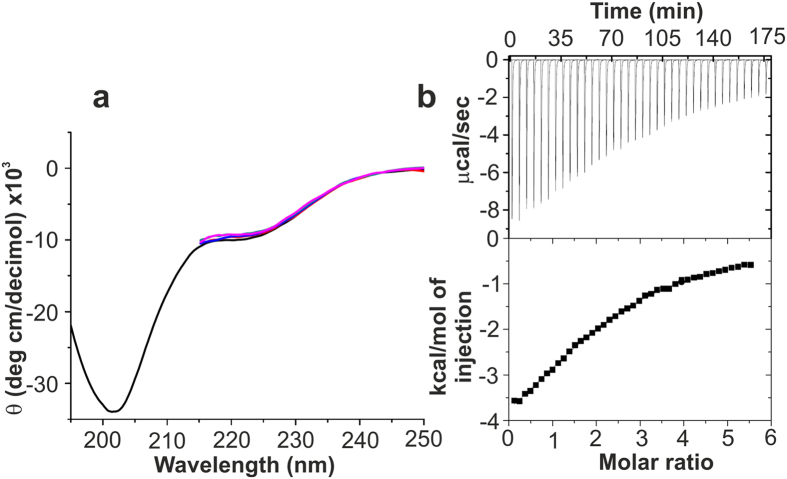
Binding analysis of the Zn complex with peptide hormones.(a) CD spectra of PTH(1–34) upon titration with the Zn complex (10 μM to 50 μM). The black spectrum corresponds to free PTH(1–34). Spectra beyond 215 nm could not be recorded due to the high absorption upon addition of the Zn complex (b) ITC profile and best fit of the interaction of Zn complex with PTH(1–34). Top: raw data obtained from injections of the Zn complex into the PTH(1–34) solution. Bottom represents the integrated curve showing the experimental points (■) and best fit (–).